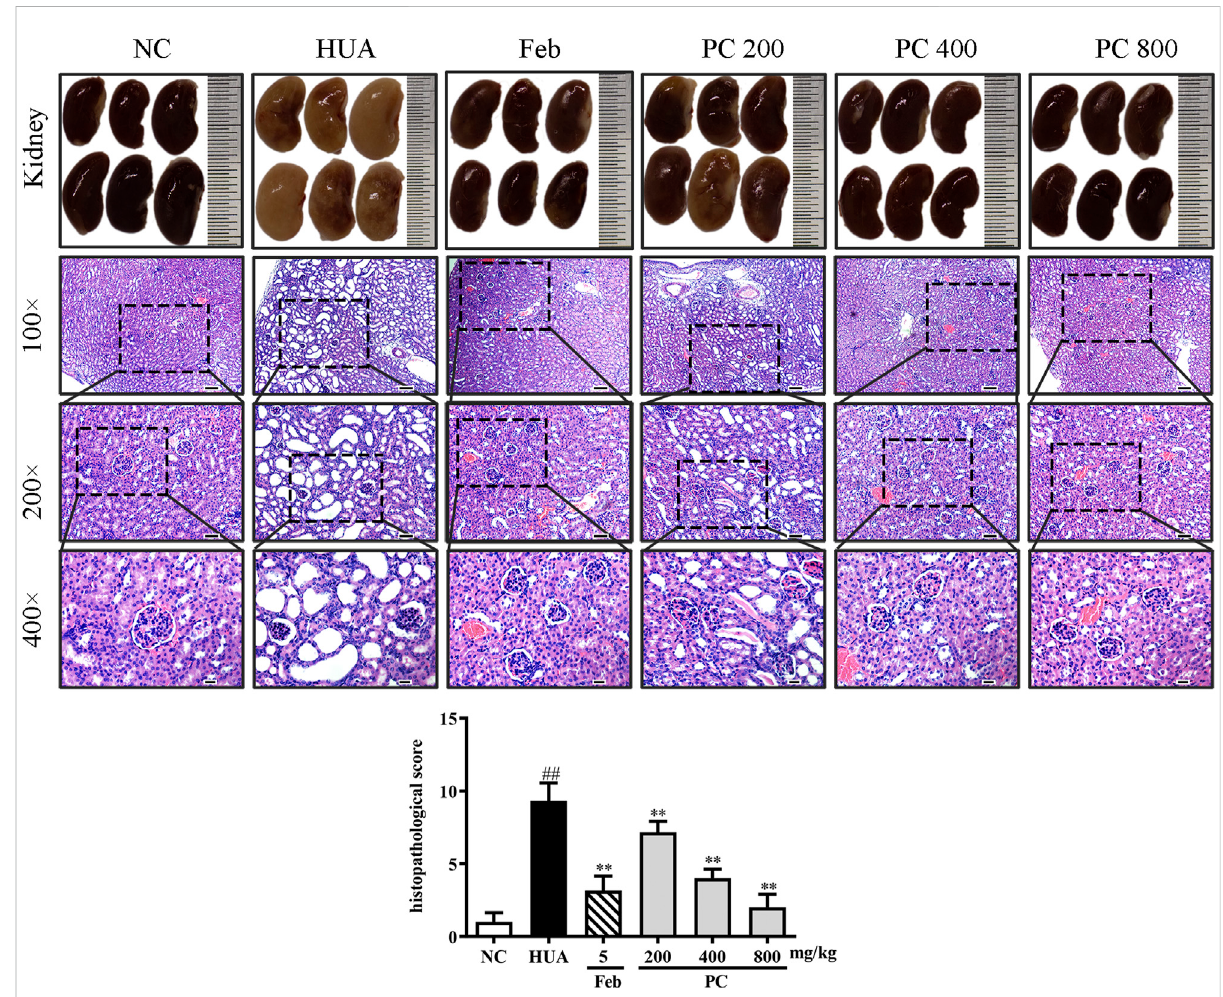
FIGURE 9 EffectsofCPonkidneygeneralstatusandhistopathologicalchangesinPO/HX-inducedHUAmice.Grossappearanceofthekidneysfromallsix groups were photographed, and sections were subjected to H&E staining; these representative photographs were taken at a magni fi cation of 100 × (scale bar 100 μ m), 200× (scale bar 50 μ m), 400× (scale bar 20 μ m),